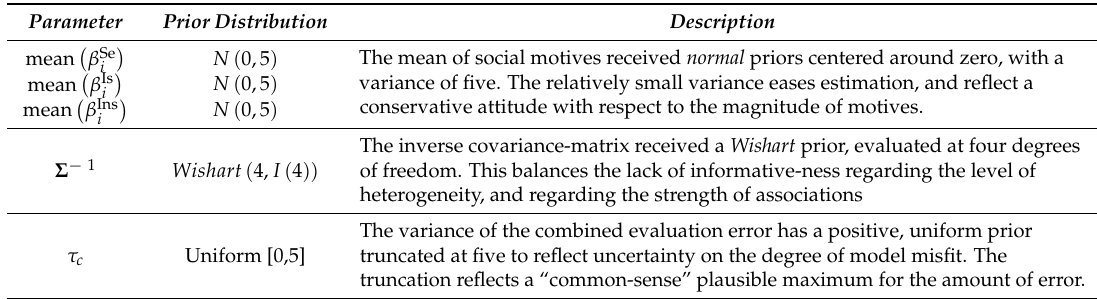
Table 5. Priors for the main model’s